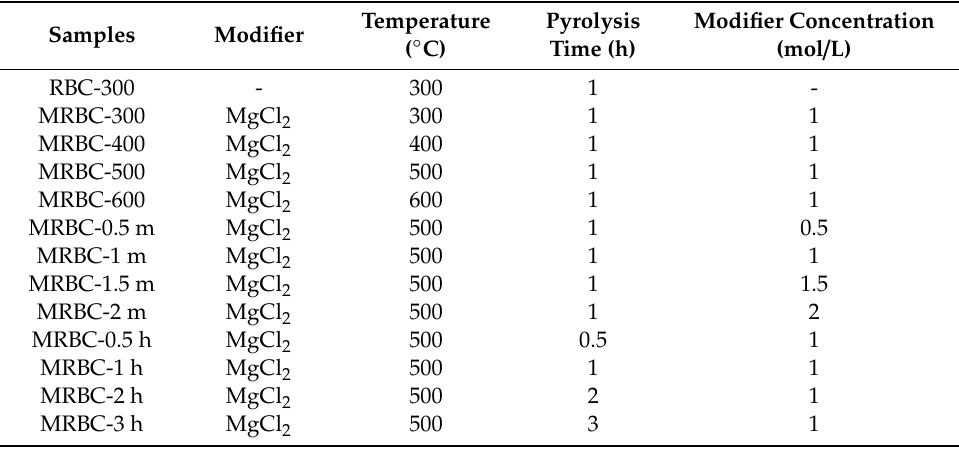
Table 1. Rice straw biochar prepared by di ff erent modification